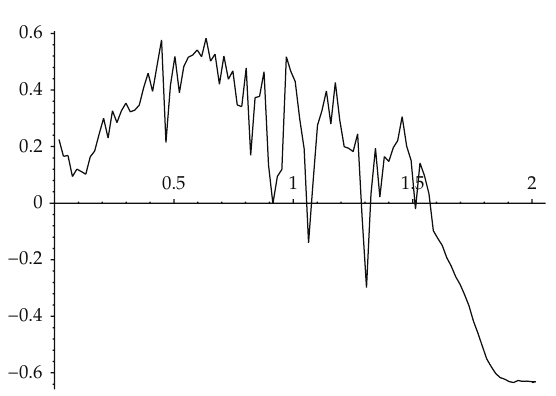
Figure 6: The largest Lyapunov exponents (cid:5) LLE (cid:6) for system (cid:5) 1.1 (cid:6) with p varying between 0 and